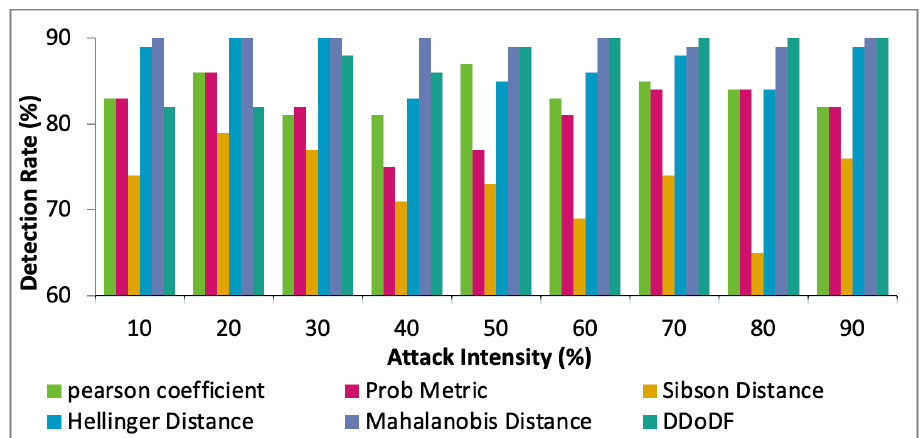
Figure 12. Attack intensity vs. false-negative rates.